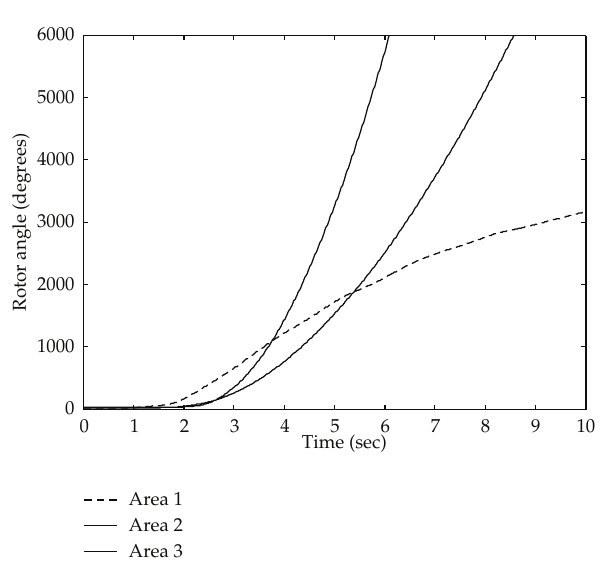
Figure 7: Case 1: all area rotor angles go out of step due to the fault at line